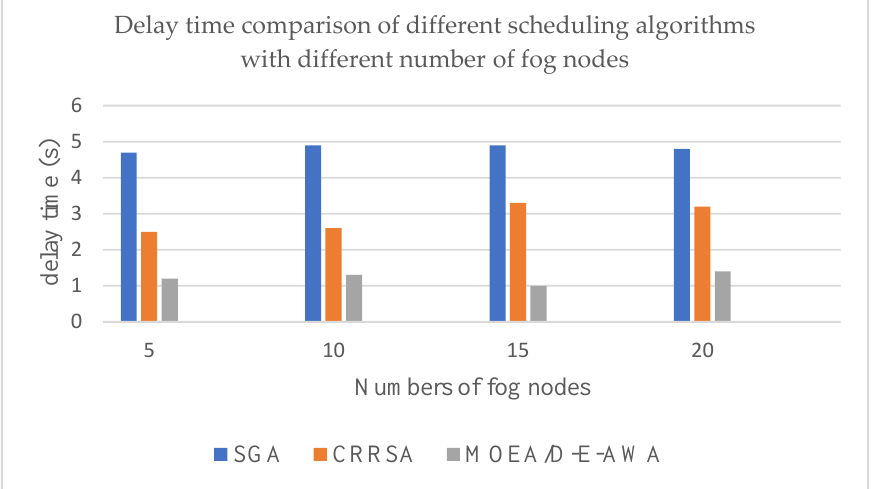
Figure 6. Comparison of delay time.